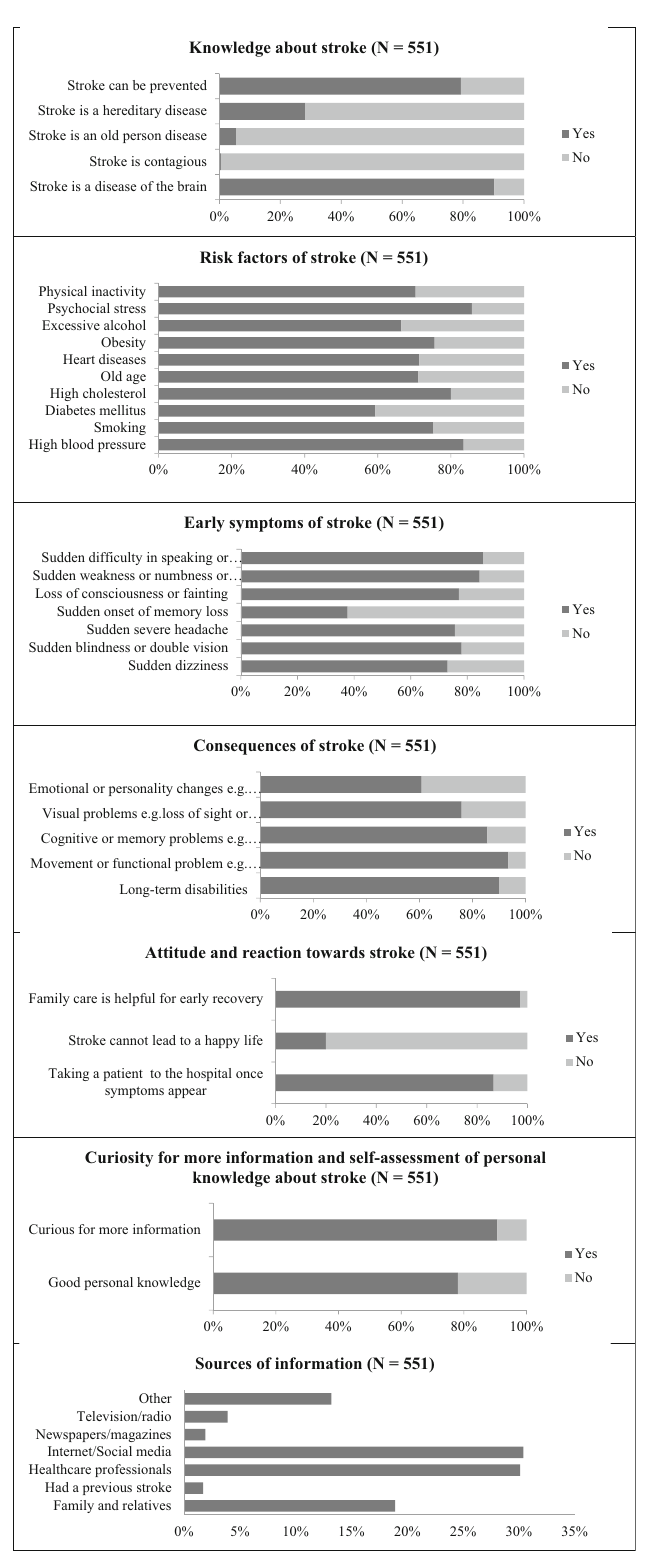
Figure 1. Percentages (%) of responses regarding stroke ’ knowledge, risk factors, early symptoms, attitude and reaction toward stroke, consequences, and sources of